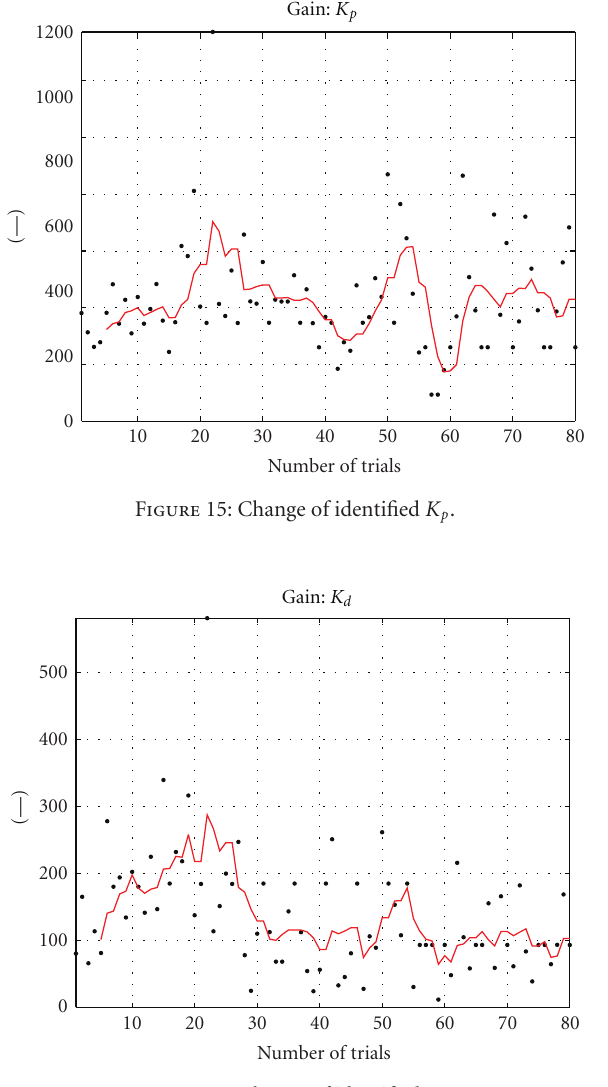
Figure 16: Change of identified K d